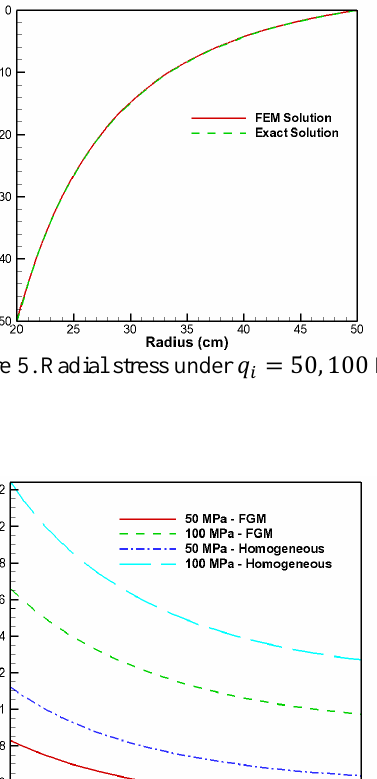
Figure 7. Displacement under 𝑞